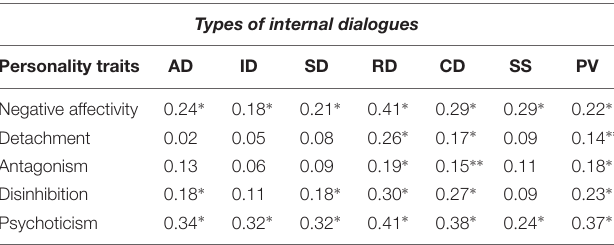
TABLE 3 | Pearson’s correlation for pathological personality traits (PID) and internal dialogicality (IDAS).